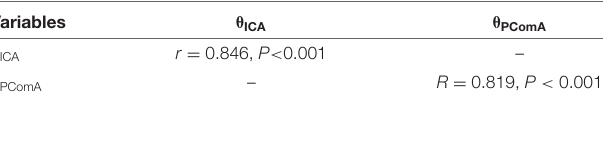
TABLE 4 | Pearson’s correlation between tortuosity and angles.